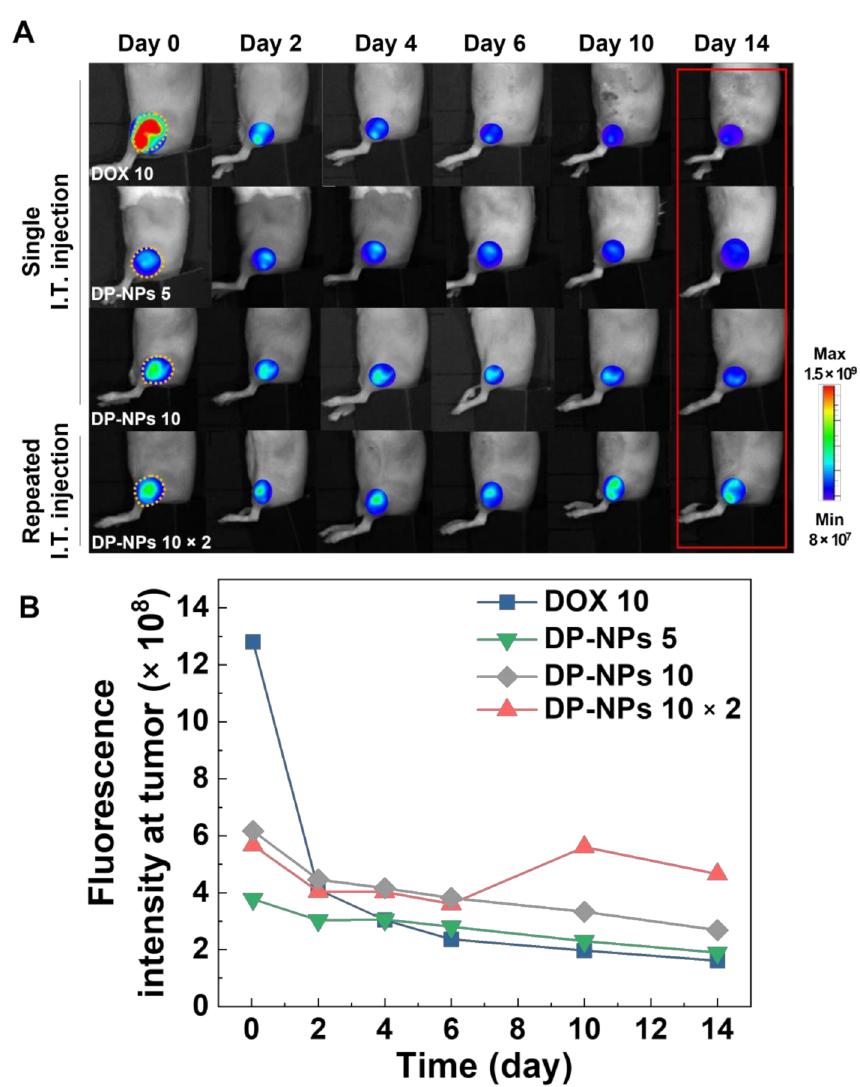
Figure 3. In vivo drug release characteristics of DP-NPs after their intratumoral injection. ( A ) Time- dependent fluorescence images of the CT26 tumor-bearing mouse intratumorally injected with DOX-HCl (10 mg/kg) and DP-NPs (5, 10, 10 × 2 mg/kg) for 2 weeks. ( B ) Quantified fluorescence intensity of DOX at the tumor tissues standing on the basis of the images from ( A